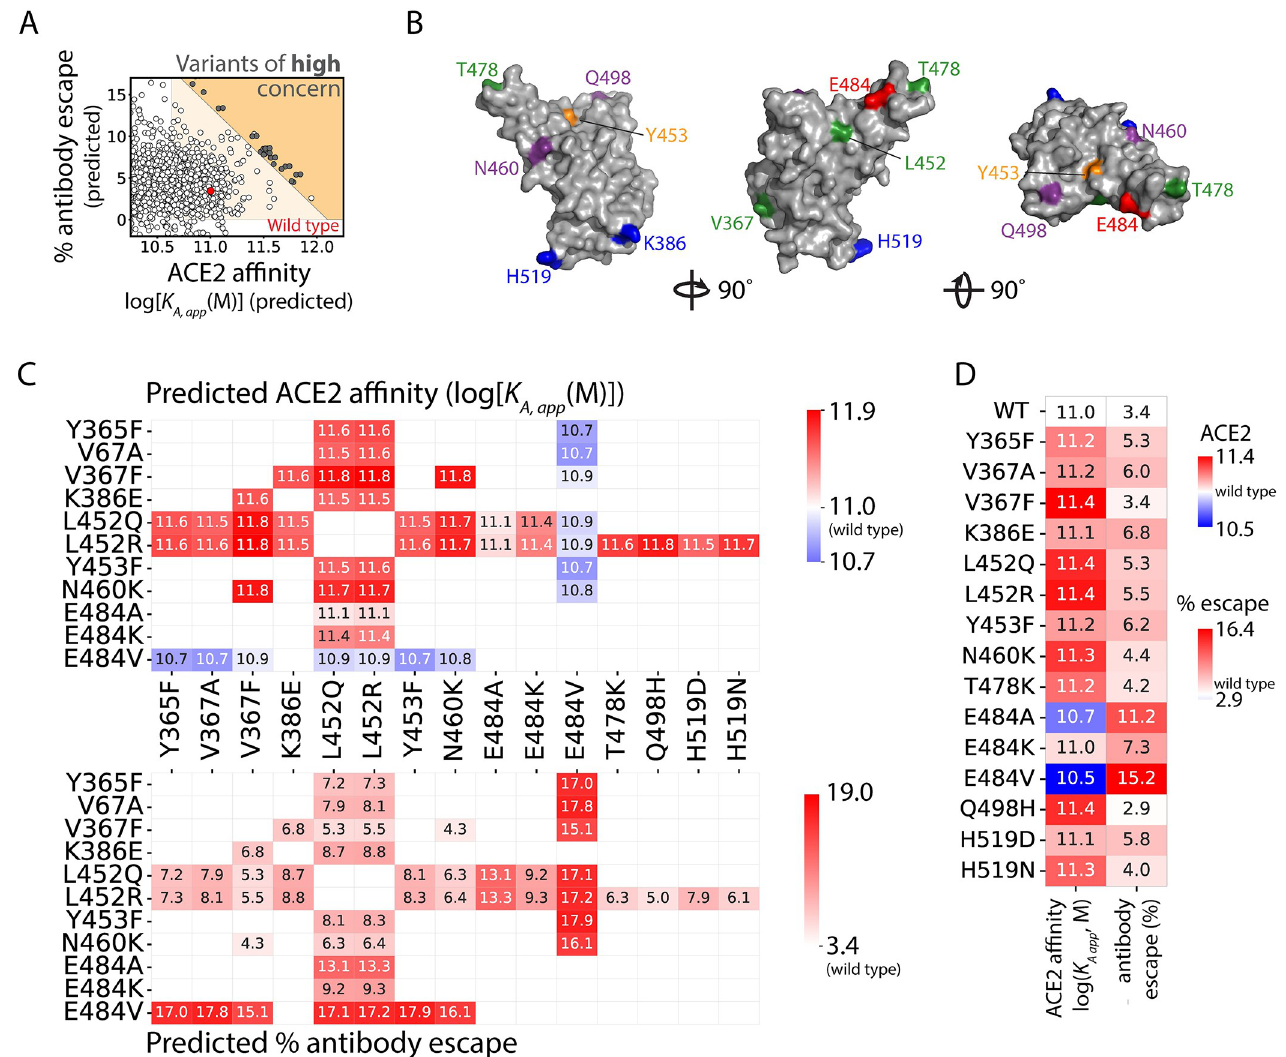
Fig 3. Identification of SARS-CoV-2 RBD double mutants at the Pareto frontier with co-maximal levels of ACE2 affinity and antibody escape. (A) Twenty-nine RBD double mutants (single nucleotide exchanges, dark gray), located at the Pareto frontier, were isolated with the largest increases in ACE2 affinity or antibody escape relative to wild type (red point). The white points at the Pareto frontier required multiple nucleotide exchanges and were not considered further, and only a subset of the evaluated RBD variants (including those at the Pareto frontier) are shown for clarity. (B) Structural locations of eleven of the sixteen RBD sites mutated in the 29 RBD double mutants that resulted in the largest increases in either ACE2 affinity or antibody escape or both. (C) Structural locations of the other RBD sites that were also mutated in the 29 RBD double mutants located at the Pareto frontier. (D) Predicted values of (top) ACE2 affinity and (bottom) antibody escape for the 29 RBD double mutants located at the Pareto frontier. (E) Predicted values for the single RBD mutations observed in the RBD double mutants located at the Pareto frontier. ACE2 affinities are reported as the log[ K (M)]. In (B) and (C), the wild-type residues are A , app colored red (negative charge), blue (positive charge), green (hydrophobic), orange (tyrosine) and purple (polar).